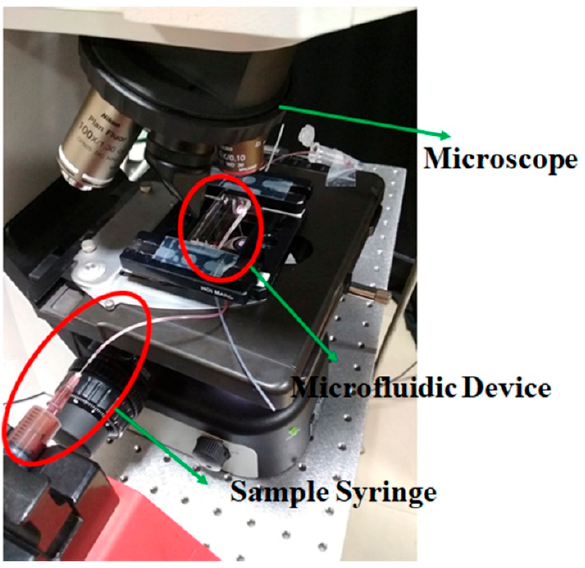
Figure 4. Experimental set-up that was used for the validation of proposed microfluidic technique.